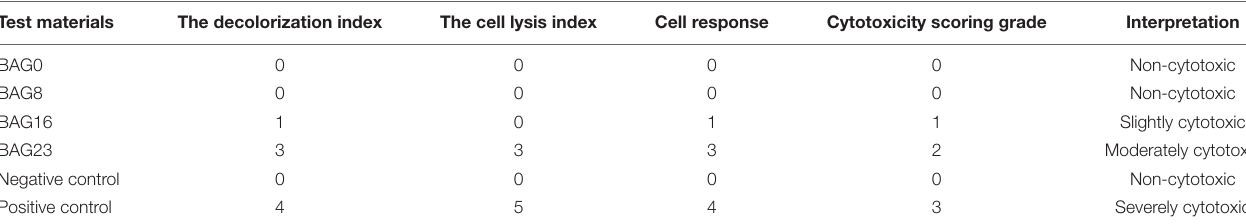
FIGURE 3 | Cytotoxicity determined by agar diffusion test. (A–C) Representative gross images of decolorization zones in the agar diffusion test. (D–I) Representative microscope images of cellular decolorization and lysis in the agar diffusion test. Bar = 200 µ m. (D) The negative control. (E) BAG0 group. (F) BAG16. (G) The positive control. (H) BAG8 group. (I) BAG23 group. “–” indicates the negative control (high-density polytetrafluoroethylene sheet); “+” indicates the positive control (polyvinylchloride containing organotin additives sheet); BAG0 indicates composite resin without BAG; BAG8 indicates composite resin with 8 wt% BAG; BAG16 indicates composite resin with 16 wt% BAG; BAG23 indicates composite resin with 23 wt% BAG. TABLE 5 | Results of the agar diffusion